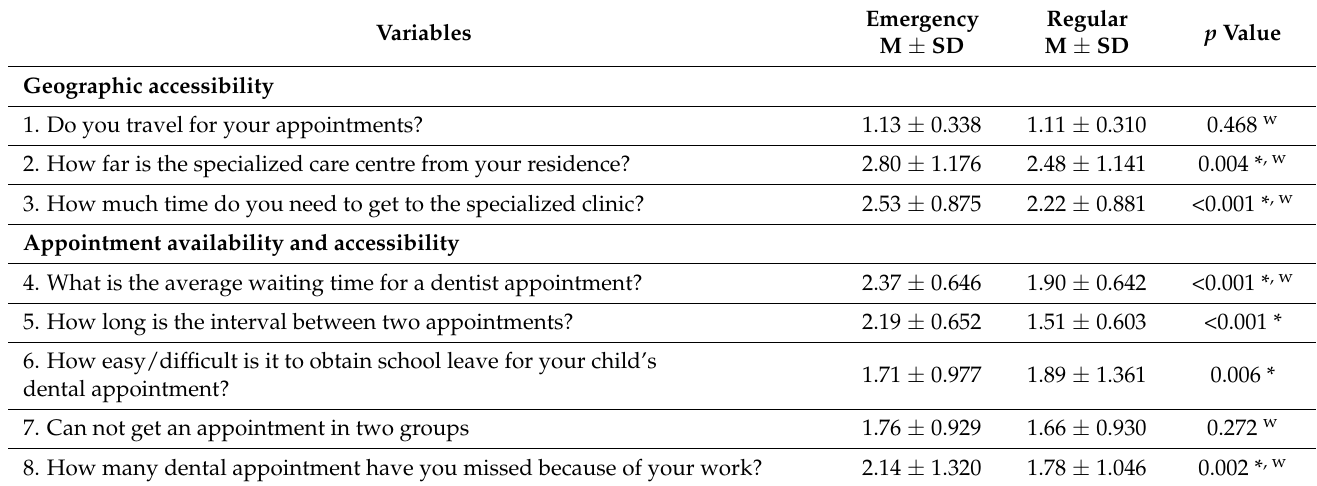
Table 3. Mean dental barrier score for children visiting emergency clinics compared to regular dental